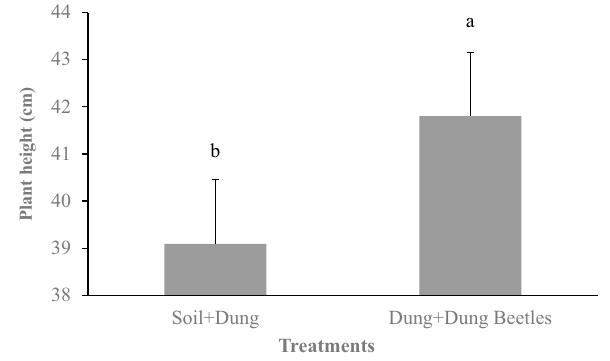
Figure 2. Pearl millet height in the presence or absence of dung beetles. Asterisk: means followed by different letters are significantly different between treatments, according to polynomial contrasts.